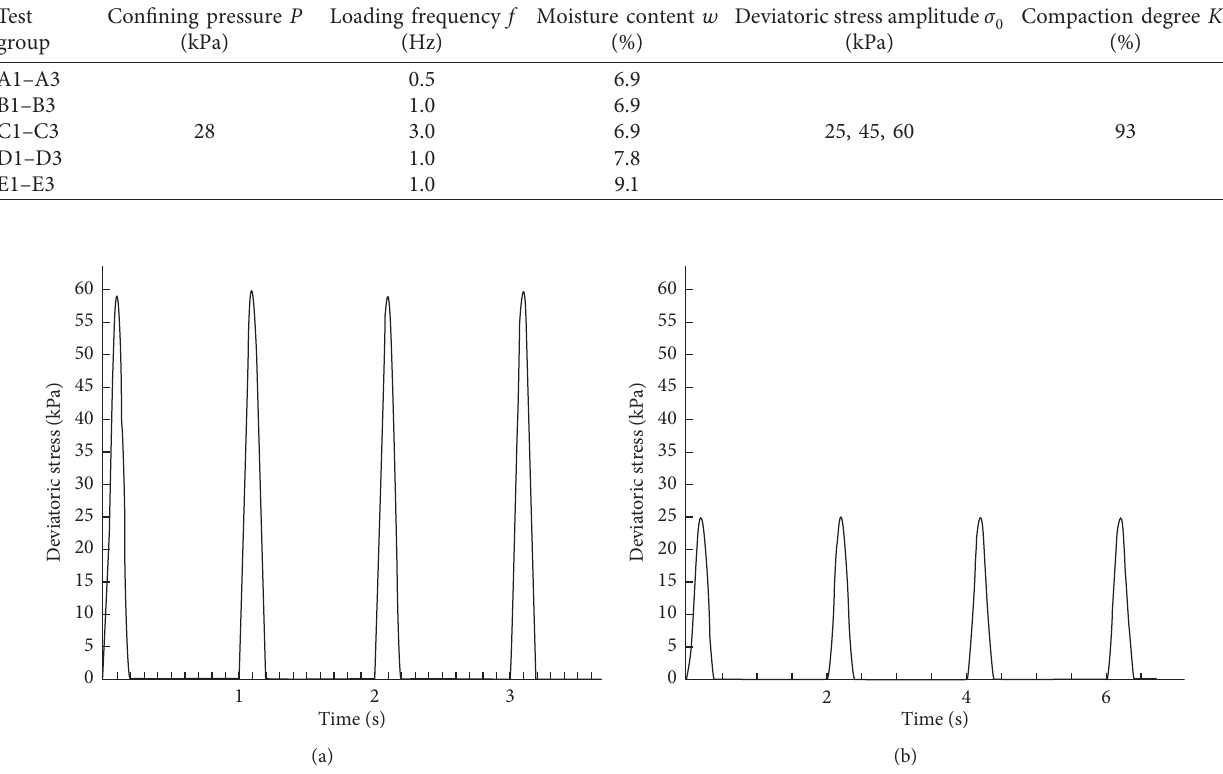
� 25kPa and f � 0.5 0